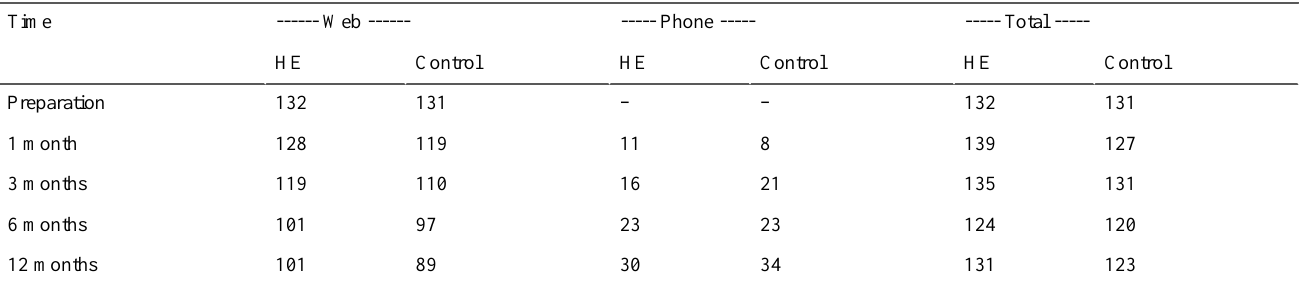
Table 4. Number of Web, phone, and total responses across conditions at specified time points; HE (n = 144) and control (n =